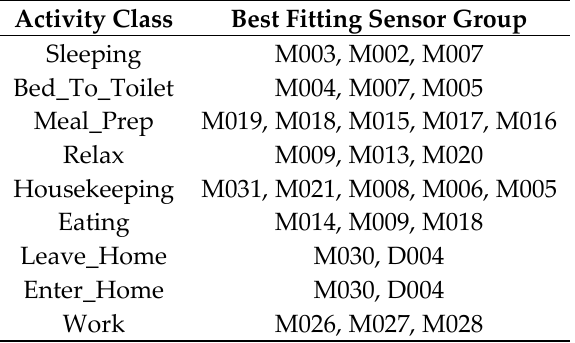
Table 1. Best fitting sensor groups for each activity. “M001” … “M031” represent motion sensors